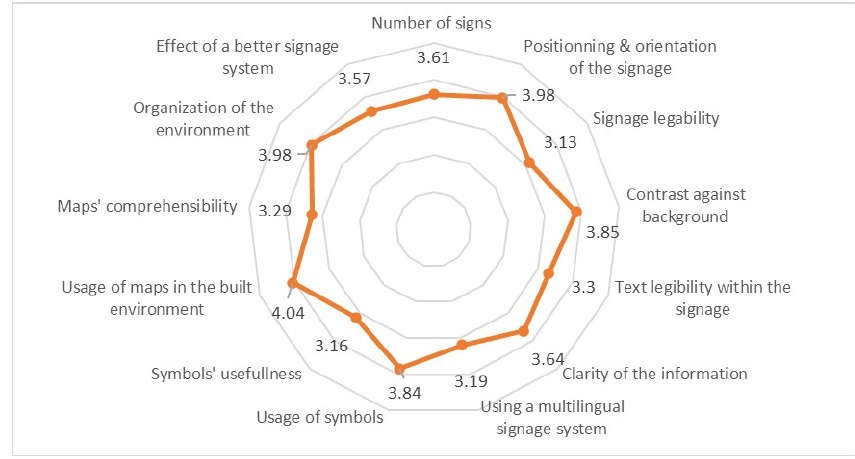
Figure 5. Subjects’ responses to the environmental items investigated in the questionnaire. Results are expressed as mean values.